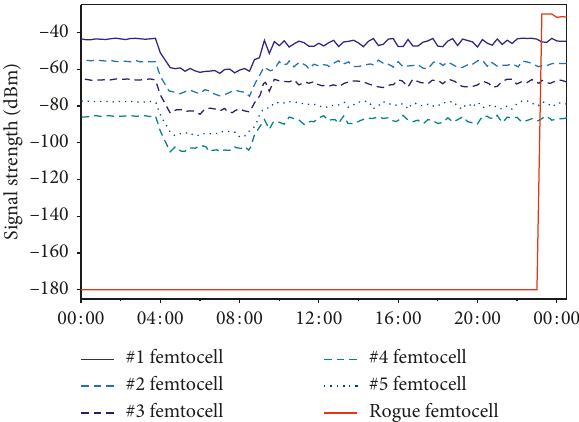
Figure 3: Signal strength profile of lawful and rogue